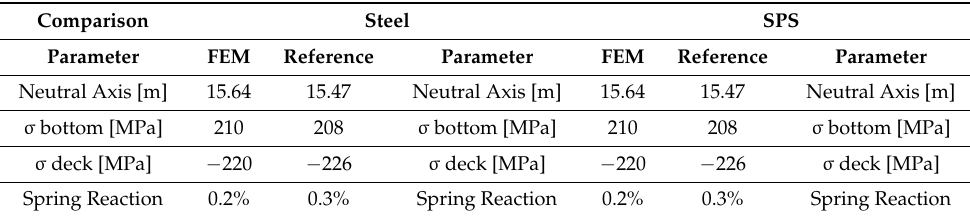
Table 11. Comparison of the static load case for both